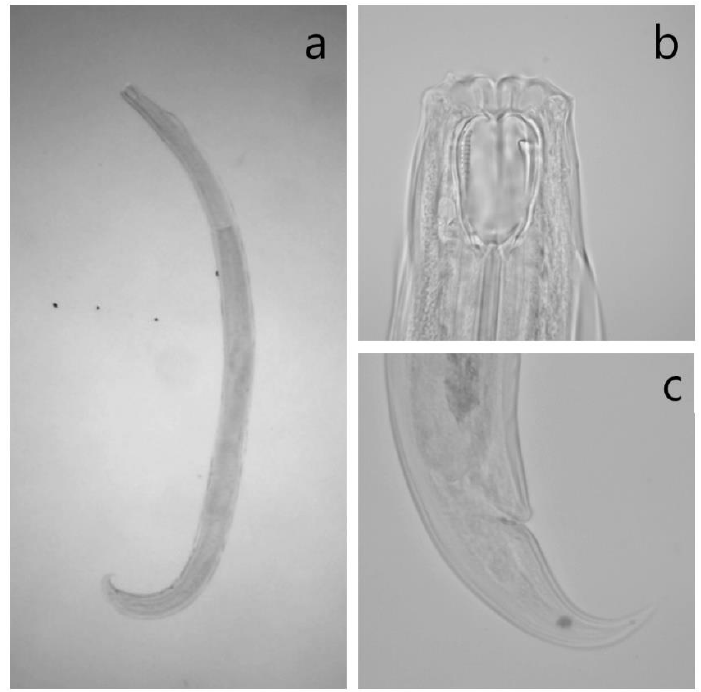
Figure A2. Mylonchulus brachyuris (Bütschli, 1873): a . habitus of female, b . lip region of female, c . tail of female, d : posterior part of male; at 200× magnification: a , at 400× magnification: b , c , d . Gödöllő, Hungary.